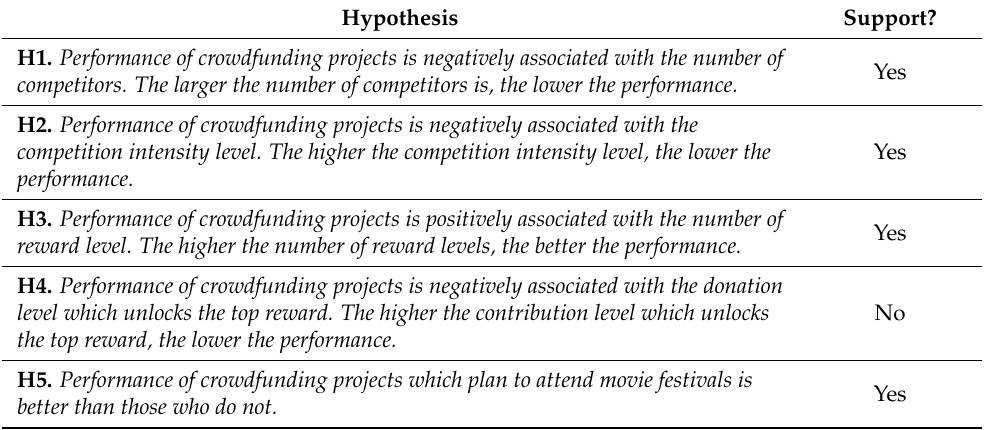
Table 4. Summary of hypotheses testing